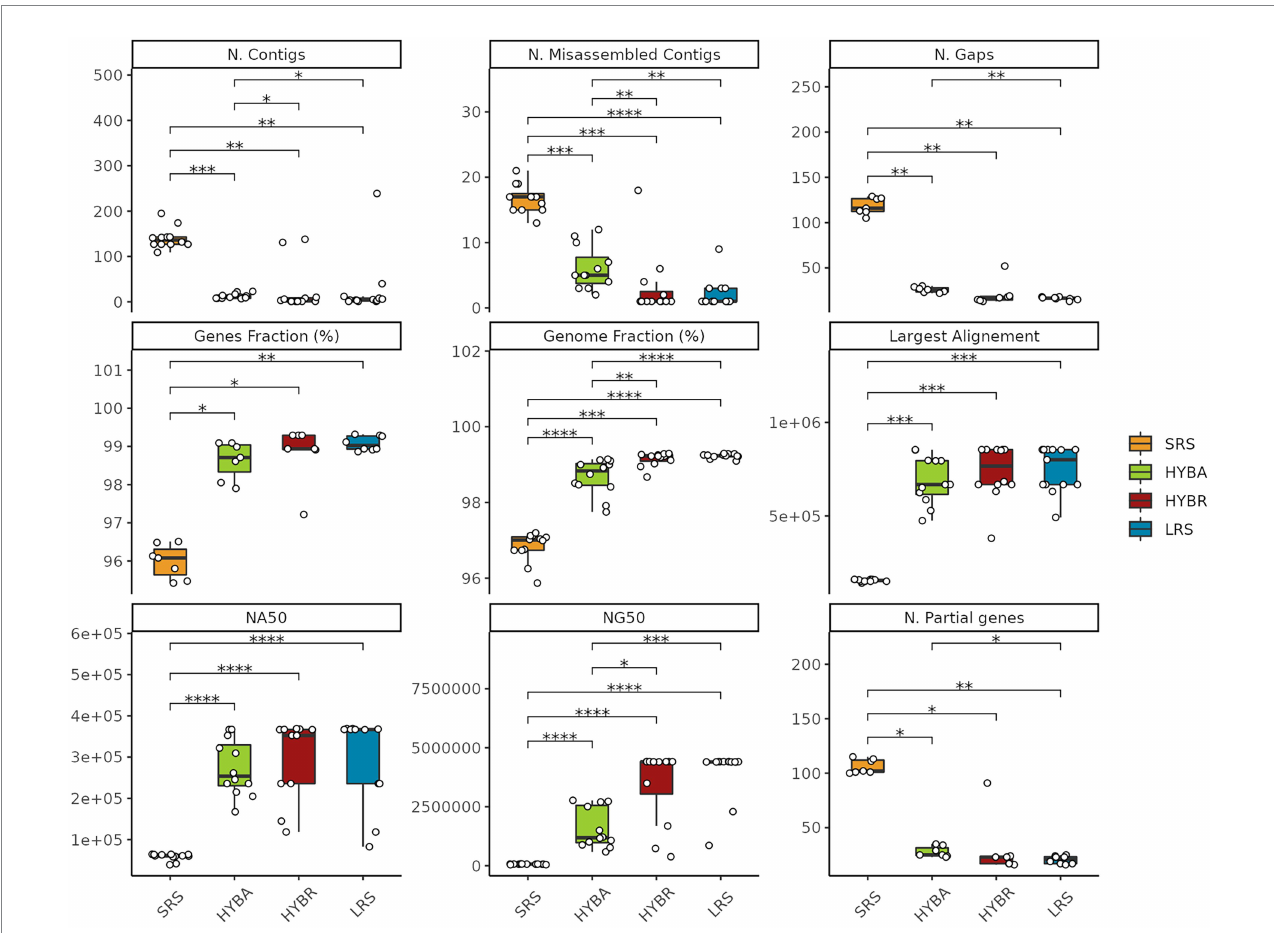
FIGURE 5 Assemblies statistics comparison. SRS in yellow, Hybrid assembly (HYBA) in green, HYBR in red, LRS in blue. * p < 0.05; ** p < 0.01; *** p < 0.001; **** p <